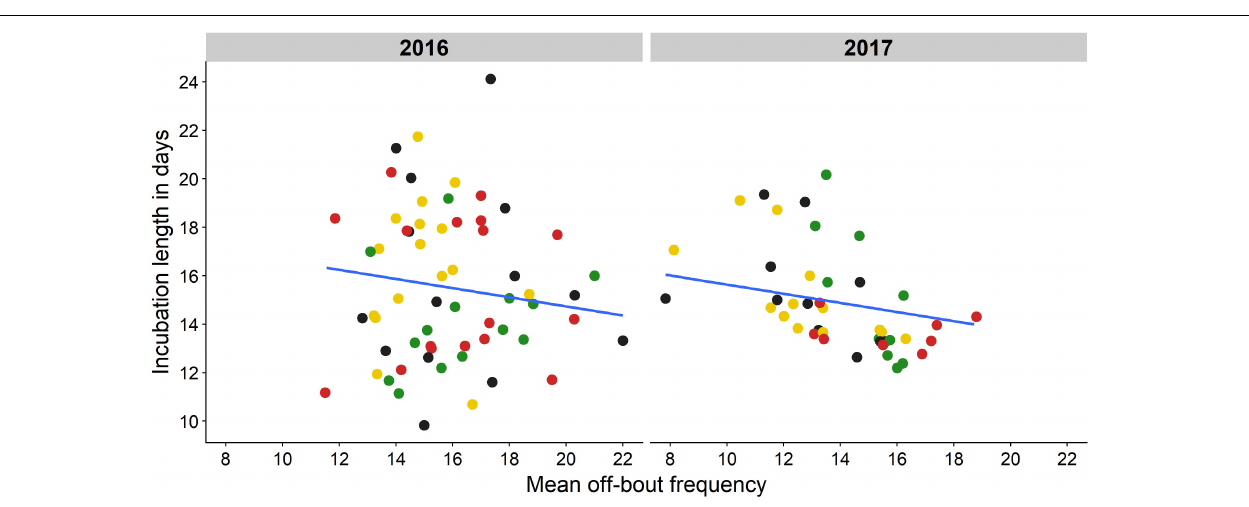
FIGURE 5 | Relation between off-bout frequency and incubation length in days. Mean off-bout frequency during the incubation period is shown for each monitored nest in relation to incubation length in days (green: green light, red: red light, yellow: white light, black: no light). The line shows the significant negative relationship as predicted by a linear mixed model (estimate = − 0.19 days, SE = 0.12, F = 5.47, P = 0.02), with a shorter incubation length when females took on average more off-bouts on incubation days. Artificial light treatment did not affect incubation length ( P = 0.60) nor was it affected by average night nest temperature (estimate = − 0.12 days, SE = 0.09, F = 1.37, P = 0.24, Supplementary Tables 6, 7 ). P = 0.04], with a similar trend compared to the red treatment [estimate = − 2, z(Inf) = − 2.59, P = 0.08], but not compared to the birds in the dark [estimate = − 0.27, z(Inf) = − 0.38, P = 1.00]. Although off-bout frequency increased over the